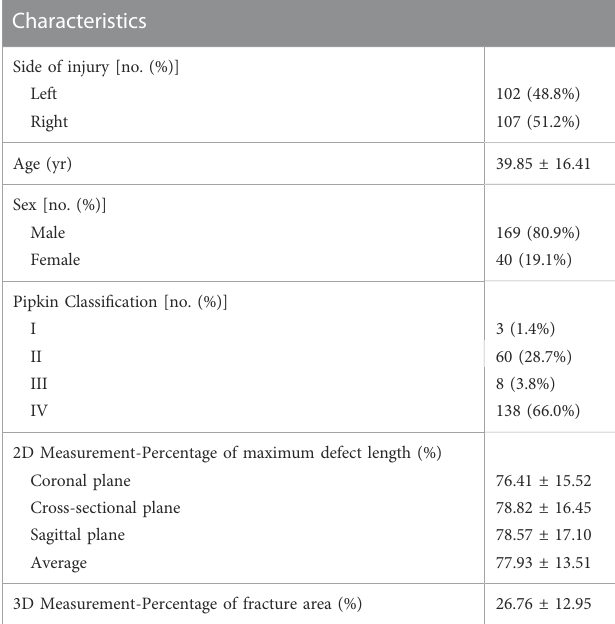
TABLE 1 Background characteristics of patients with femoral head fractures.